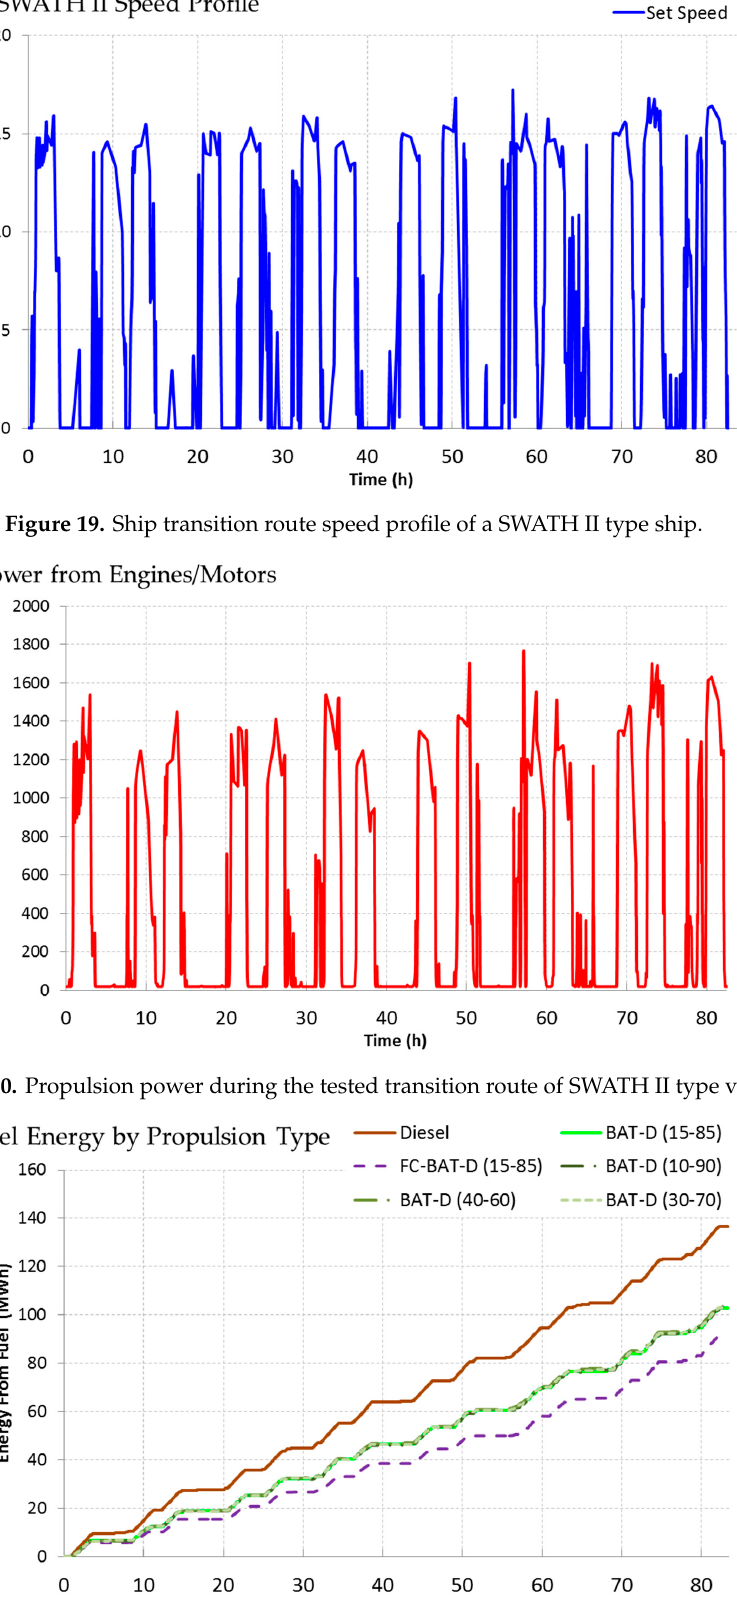
Figure 21. Time plot of consumed fuel energy, depending on the selected configuration of powertrain: Diesel, BAT-D (15–85), BAT-D (10–90), BAT-D (30–70), BAT-D (40–60), FC-BAT-D (15–85).